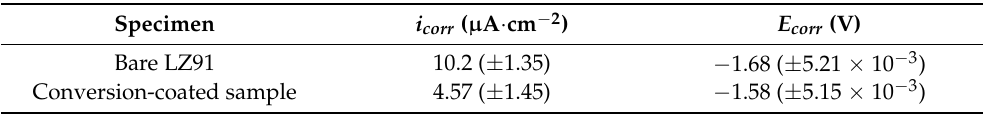
Table 3. Results for potentiodynamic polarization tests for bare LZ91 and the conversion-coated